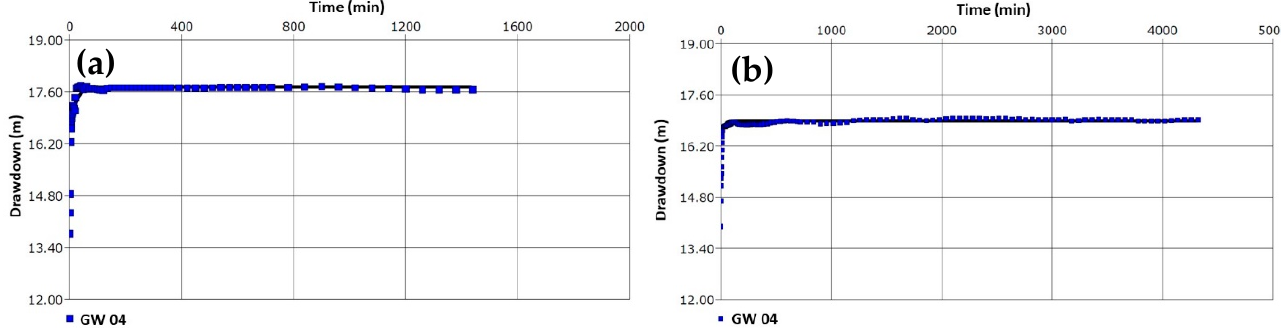
Figure 13. Continuous pumping test curves of deep confined aquifer (aquifer C): GW 04 for 24 h ( a ) and 72 h ( b ).